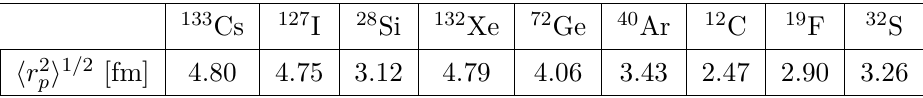
Table 1. Isotopes and respective nuclear radius values, taken from